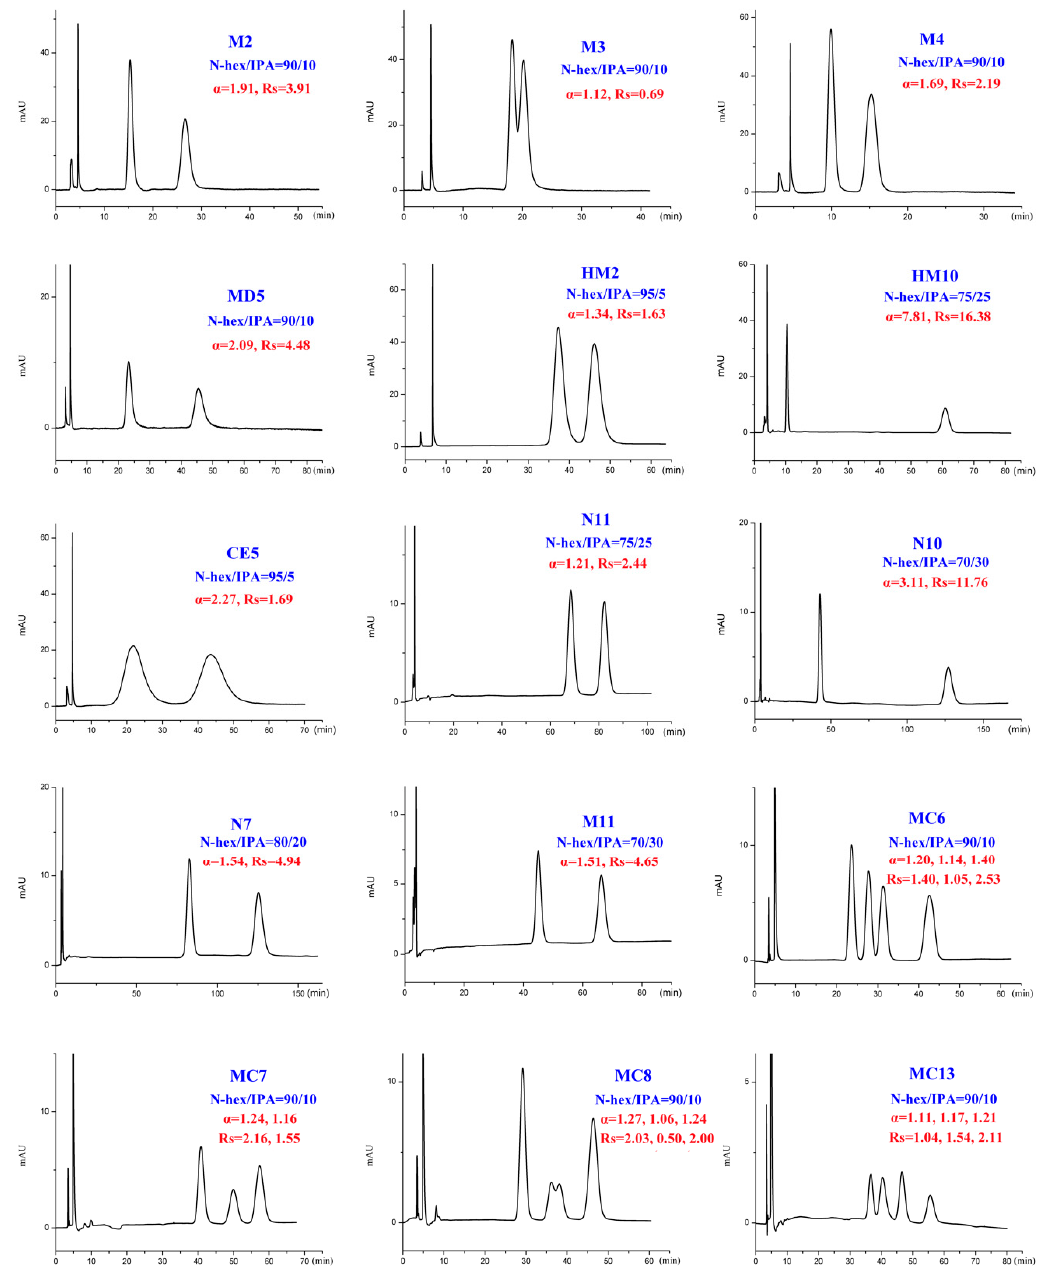
Figure 2. Typical chromatograms with isopropanol (IPA) as organic modifier under normal-phase mode; enantioselectivity factor ( α ) and resolution (R s ).